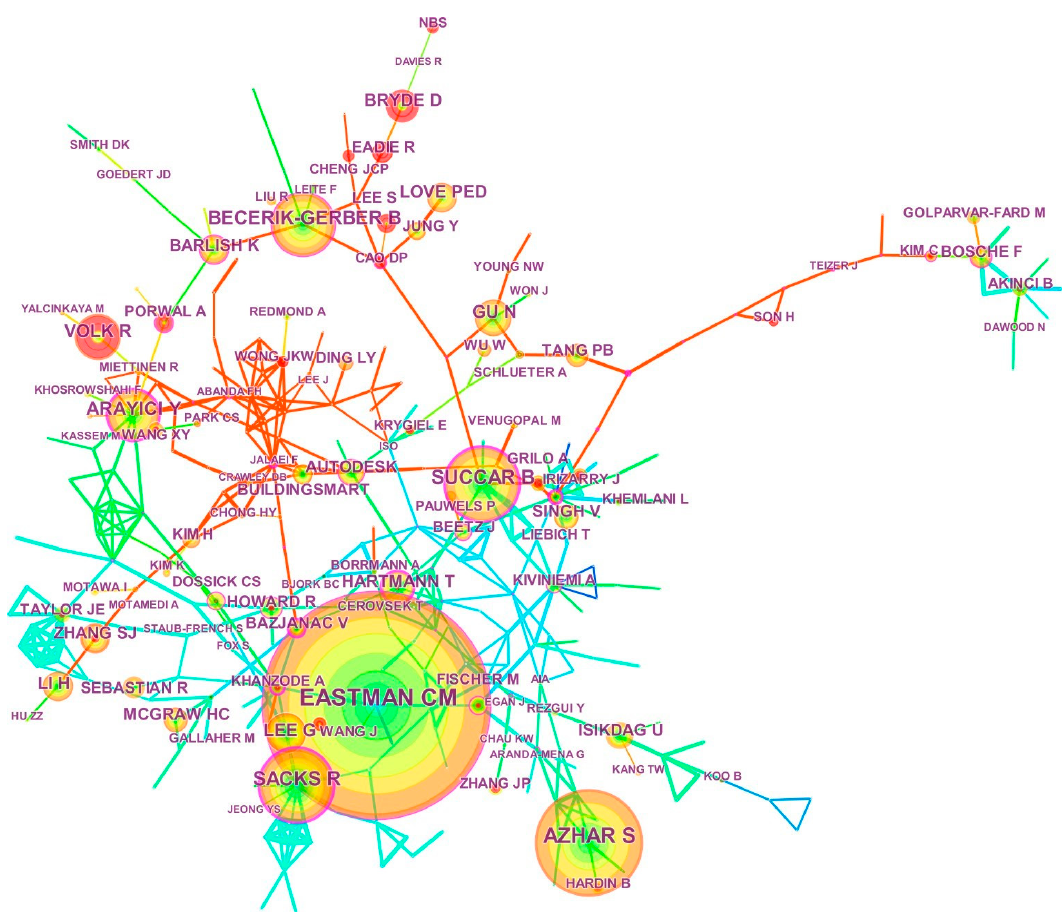
Figure 11. Author co-citation network.